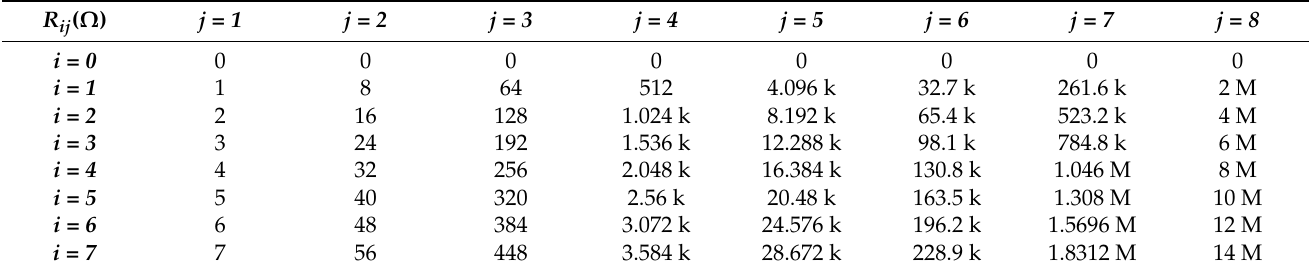
Table 2. R ij Resistance values used for